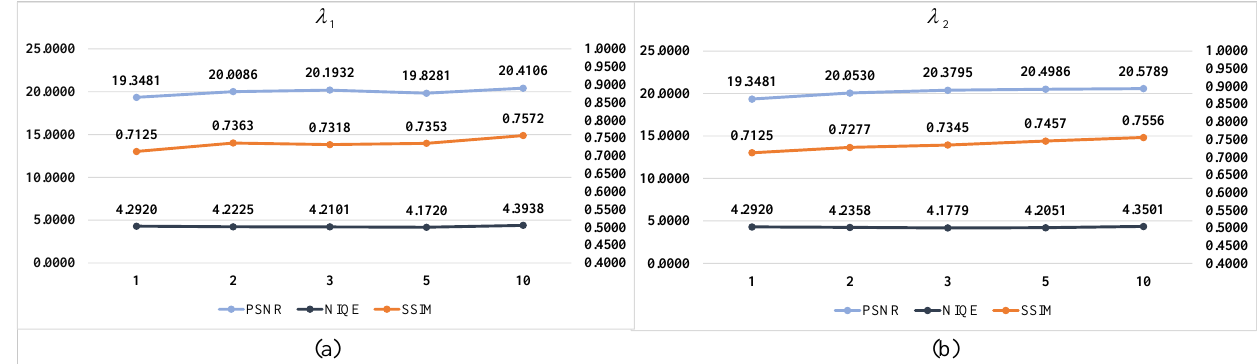
Figure 13. ( a ) Performance variation with respect to λ 1 . ( b ) Performance variation with respect to λ 2